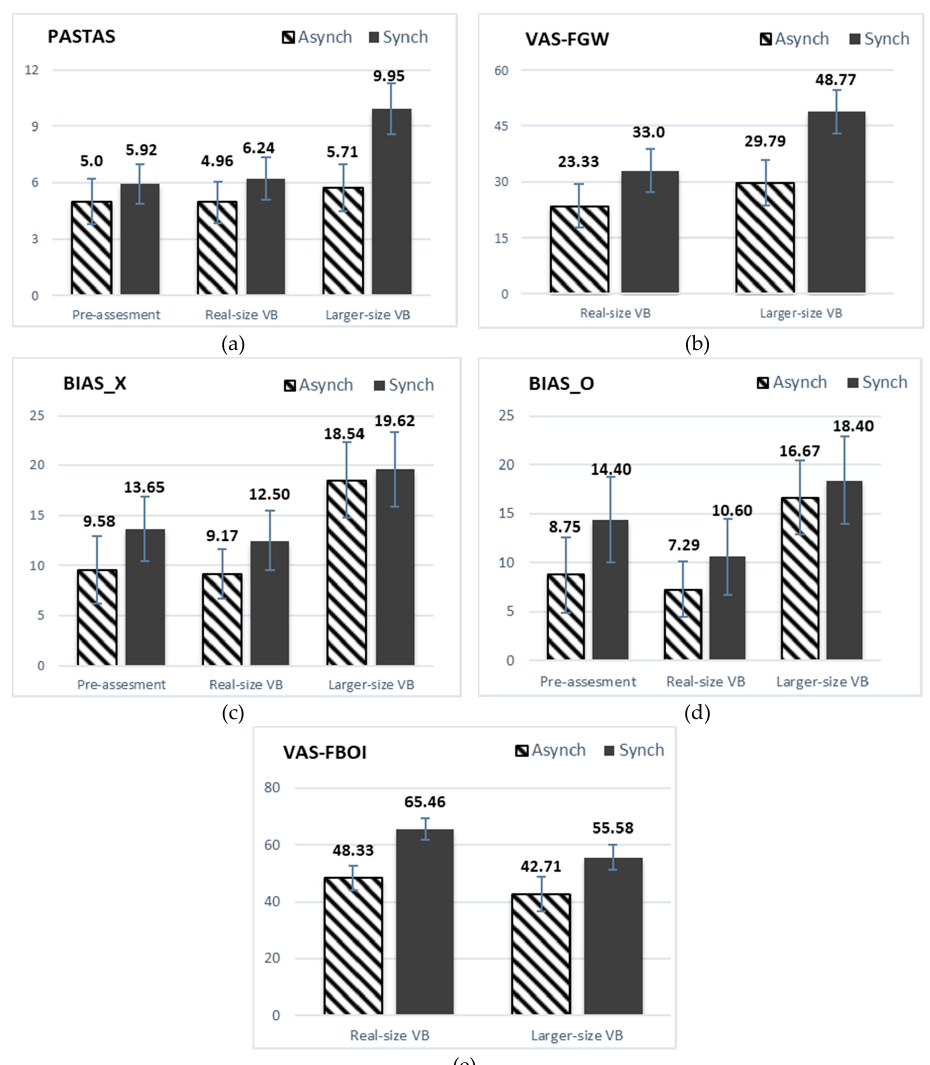
Figure 2. ( a )Body anxiety mean scores, ( b ) fear of weight gain mean scores, ( c ) body image distortion mean scores, ( d ) body image dissatisfaction mean scores, ( e ) full-body ownership illusion mean scores. Means of the asynchronous and synchronous groups in the three assessment conditions (pre-assessment, real-size virtual body, larger-size virtual body). Error bars represent standard errors. Body image disturbances (Body Image Distortion-BIAS_X, Body Image Dissatisfaction-BIAS_O), Body anxiety (PASTAS), fear of gaining weight (VAS-FWG), and full-body ownership illusion (VAS- FBI). VB = Virtual body.